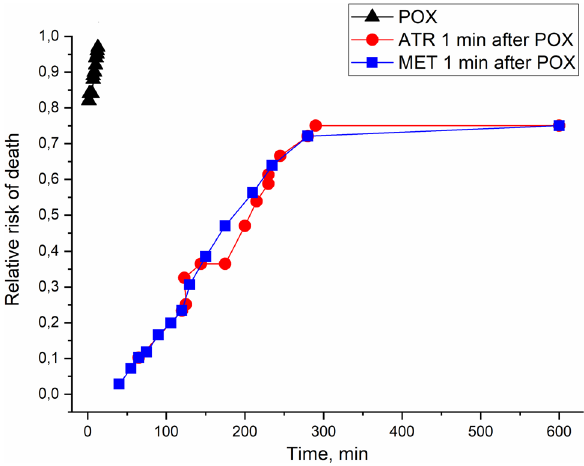
Figure 3. Cox analysis of survival data for mice treated with atropine (ATR) at a dose of 10 mg/kg or methoctramine (MET) at a dose of 8 mg/kg against a 2xLD50 dose (0.42 mg/kg, i.p.) of paraoxon (POX).